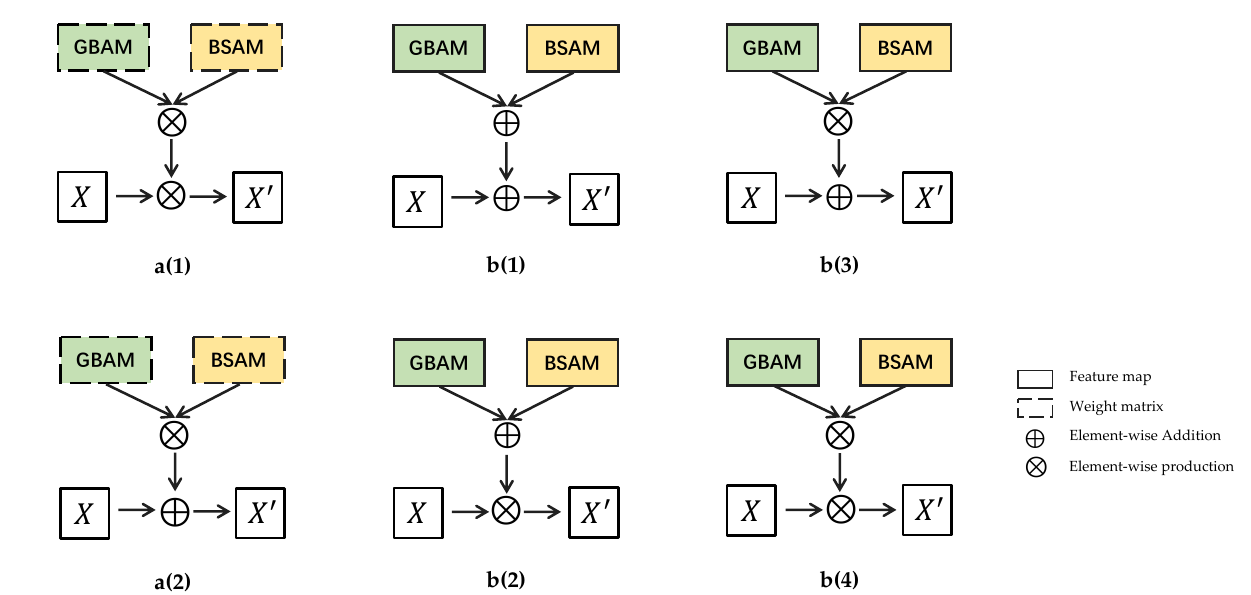
Figure 10. The illustration of multi-attention fusion strategy. ( a ) Attention weight fusion strategies, ( b ) attention feature maps fusion strategies.